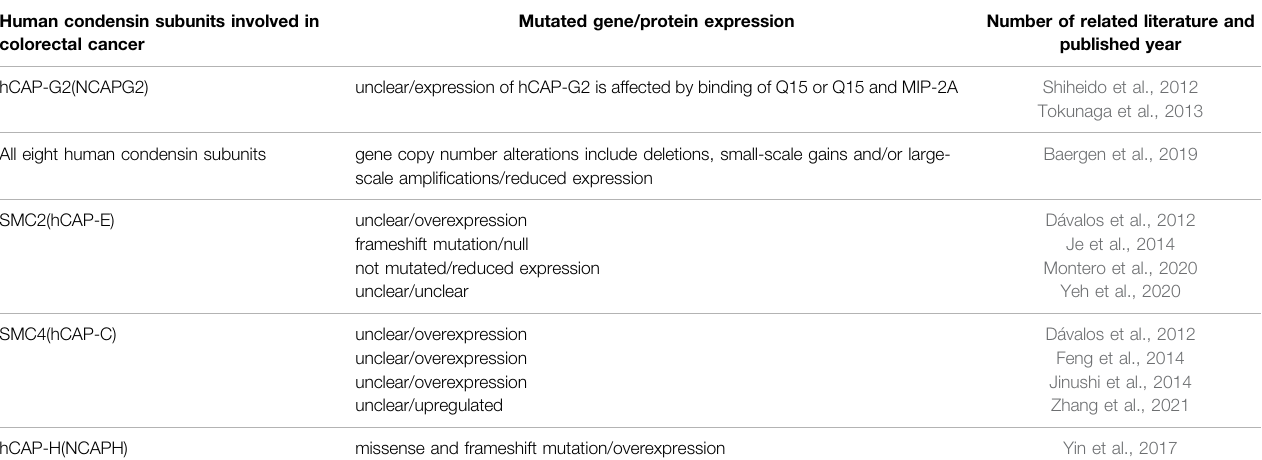
TABLE 1 | All eight subunits of human condensins involved in colorectal